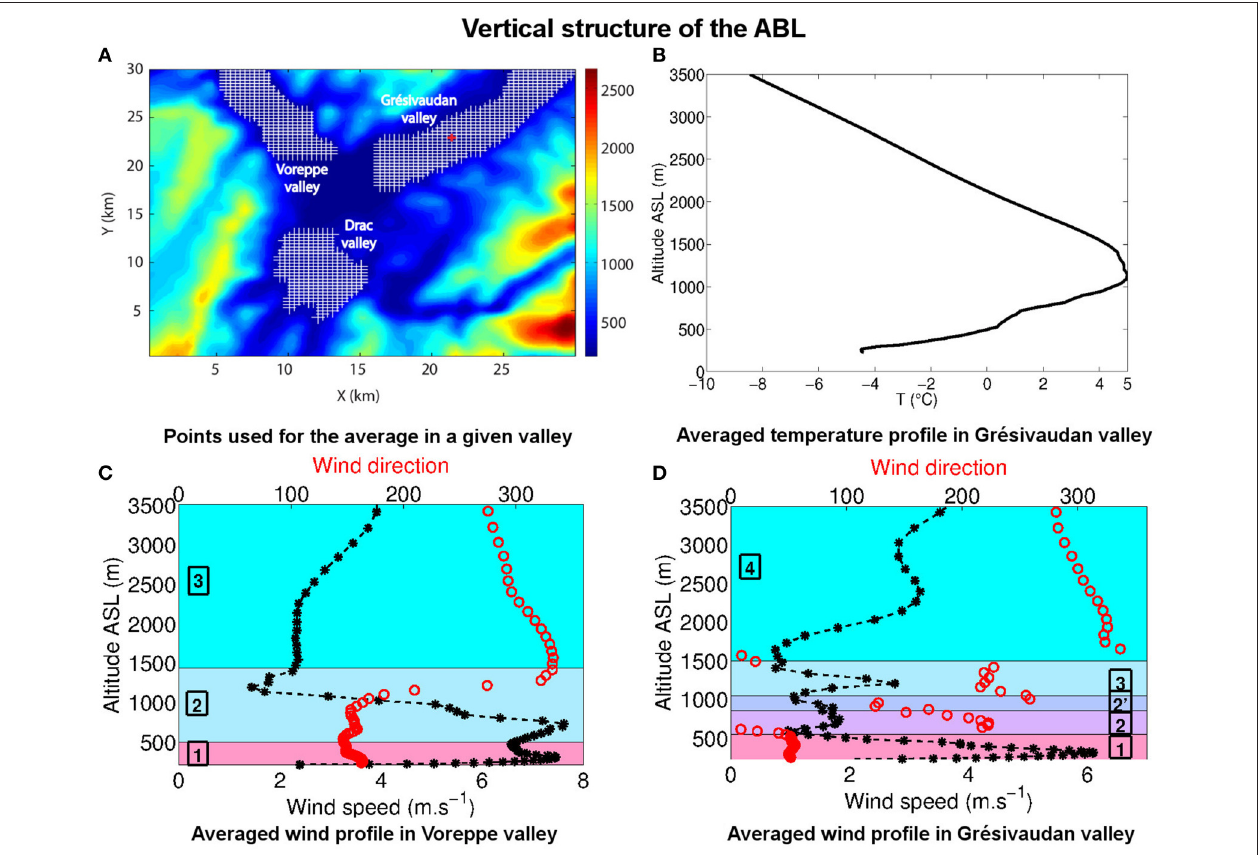
FIGURE 7 | (A) The hatched zones are those over which the average for the Voreppe valley, the Grésivaudan valley and the Drac valley are performed. The point Gr, referred to in Section 5, is indicated with a red + symbol. (B) Vertical profile of temperature averaged over the Grésivaudan valley. (C) Vertical profile of wind speed ( ⋆ ) and wind direction ( ◦ ) averaged over the Voreppe valley. (D) Same as (C) in the Grésivaudan valley. The averages are performed over the horizontal grid points displayed in frame (A) . Profiles are shown at 06:00 UTC on December 28.